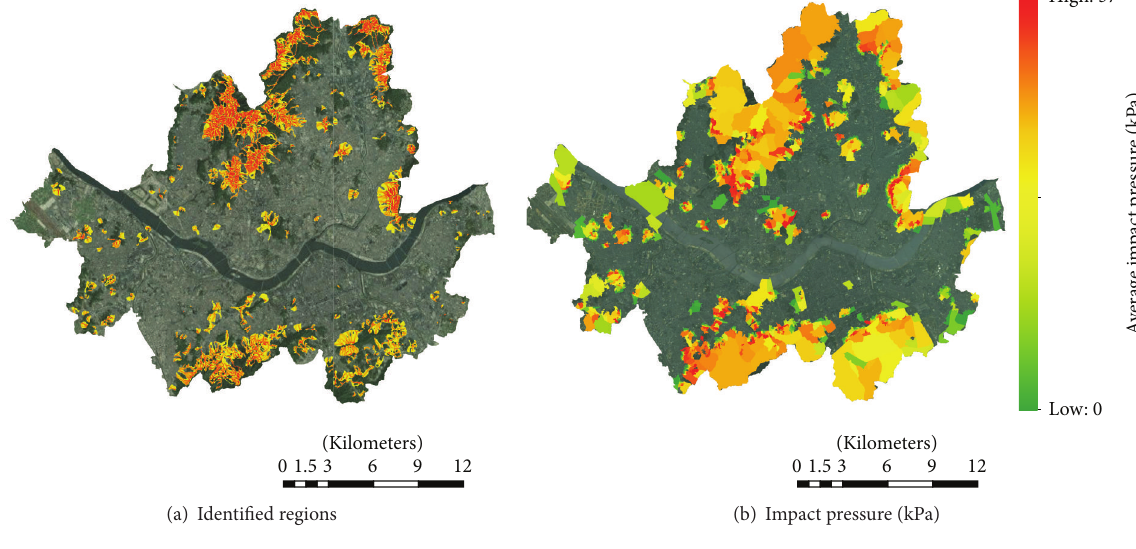
Figure 6: Results of Flow-R simulation.